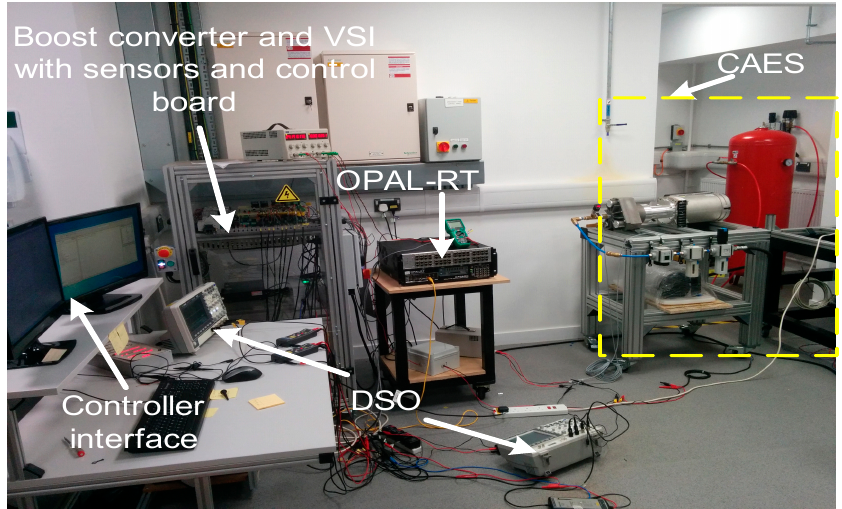
Figure 9. ( a ) Three phase inverter reference voltage, grid voltage and grid current; ( b ) inverter reference voltage and grid voltage of phase-A, ( c ) I d and I q of inverter output current; ( d ) active and reactive power flow to the grid.